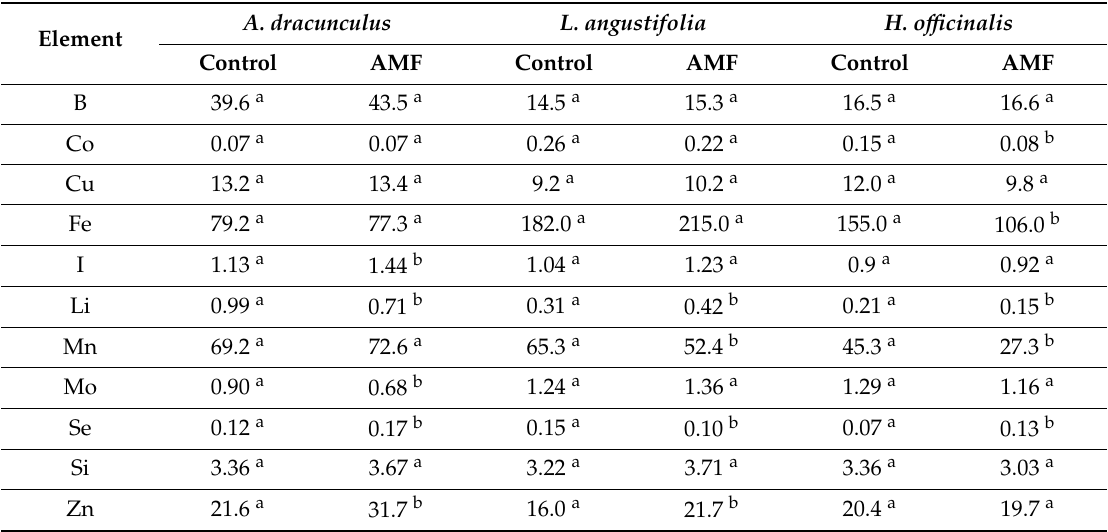
Table 5. Trace elements content in aromatic plants inoculated with AMF (mg · kg − 1 dw). Element